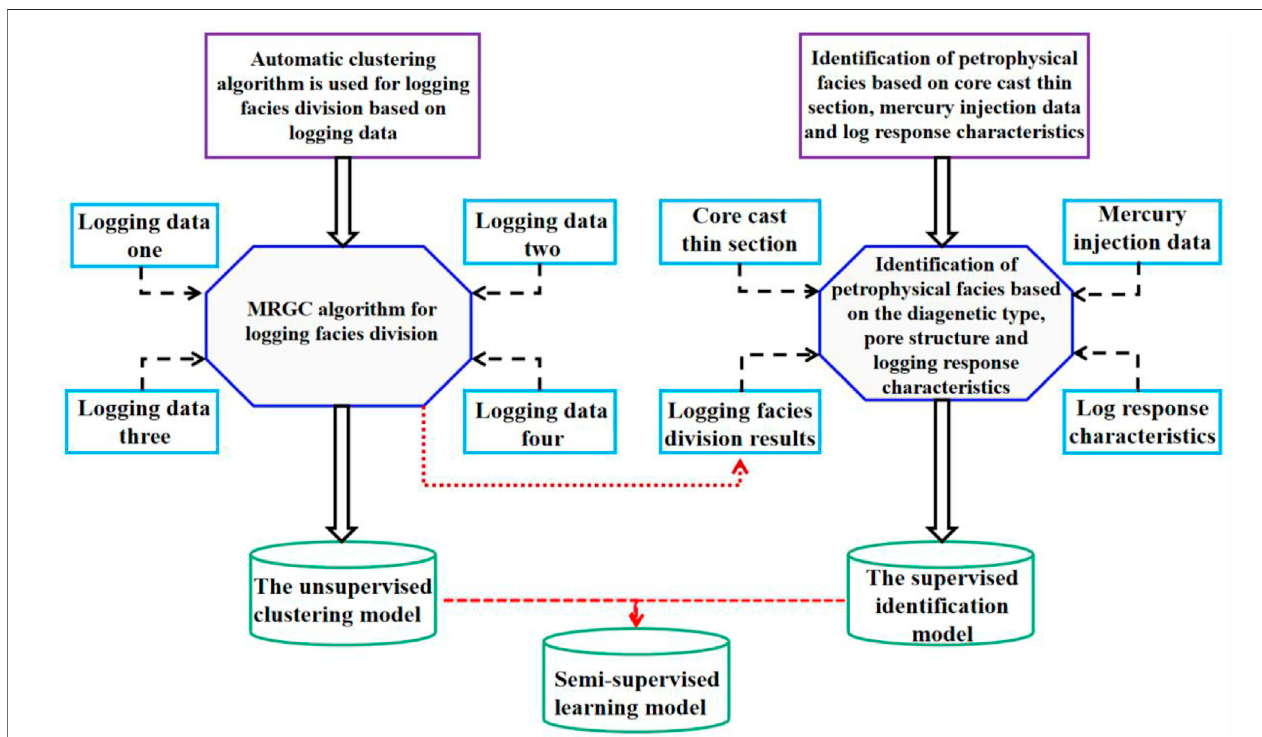
FIGURE 5 | Flowchart of petrophysical facies division based on semi-supervised learning.